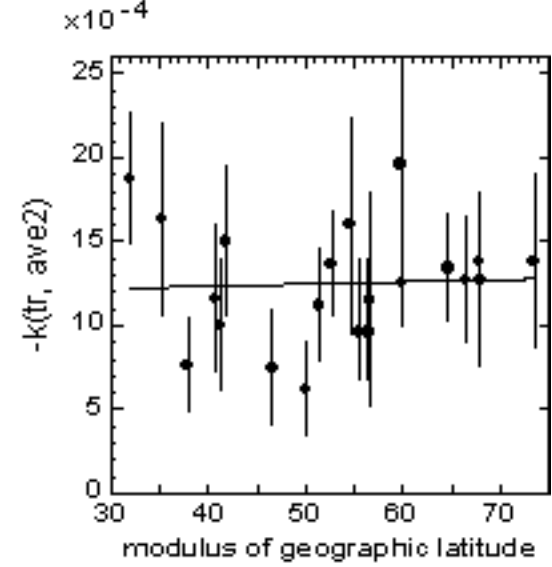
Fig. 4. The nongeomagnetic trends k(tr, ave 2 ) obtained for various stations versus the modulus of the geographic latitude (points). The line represents the regression line through the data points. The bars correspond to the σ (2) values shown in Table 3.